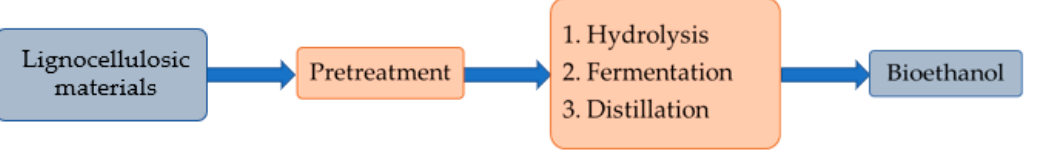
Figure 3. A bioethanol production process based on lignocellulosic materials.